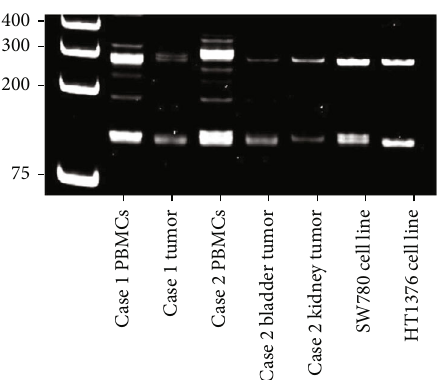
Figure 3: Short tandem repeats analysis of loci D18S51 and D3S1358 demonstrated donor-origin. STR analysis of loci D18S51 and D3S1358 of patient puri fi ed blood mononuclear cells (PBMC), patient tumors, and two bladder cancer cell lines (SW780 and HT1376) as controls. STR loci and primers were chosen from The National Institute of Standards and Technology.